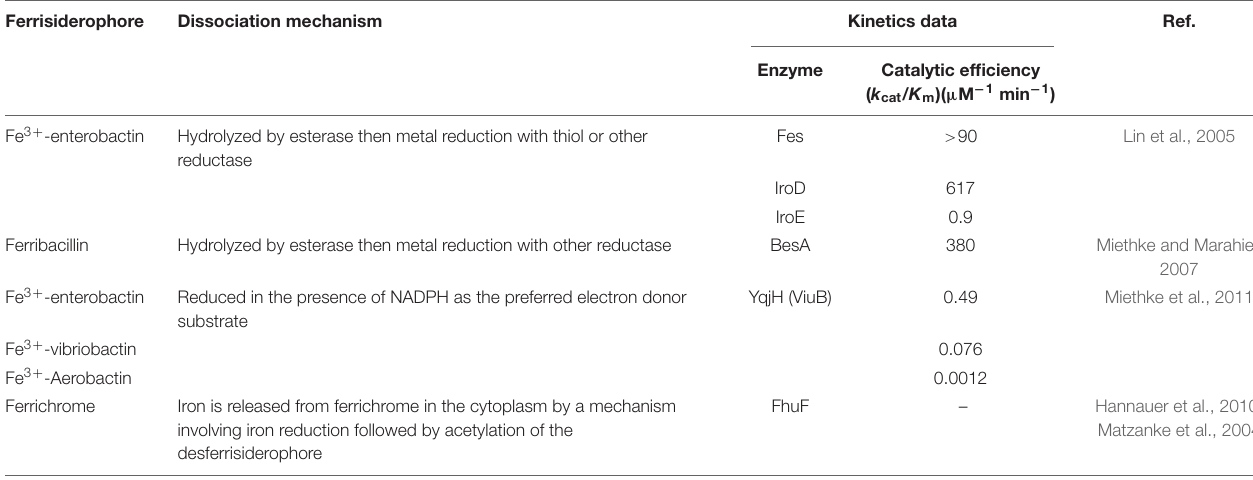
TABLE 3 | Dissociation mechanism of ferrisiderophore. Ferrisiderophore Dissociation mechanism Kinetics